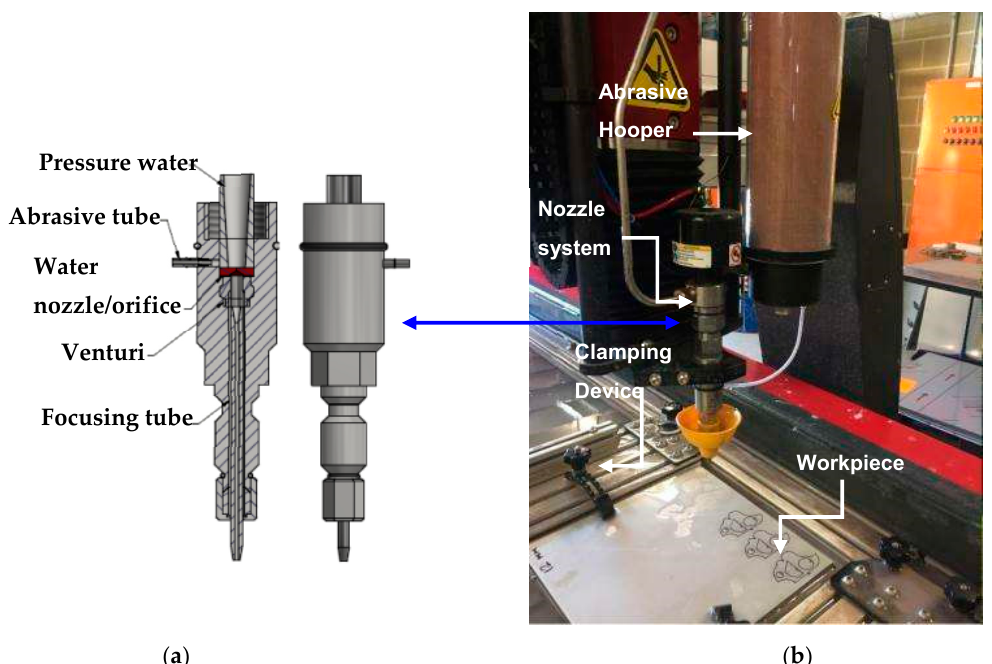
Figure 2. Experimental set-up ( a ) Schematic diagram of the nozzle system and ( b ) AWJ cutting head and material positioning.